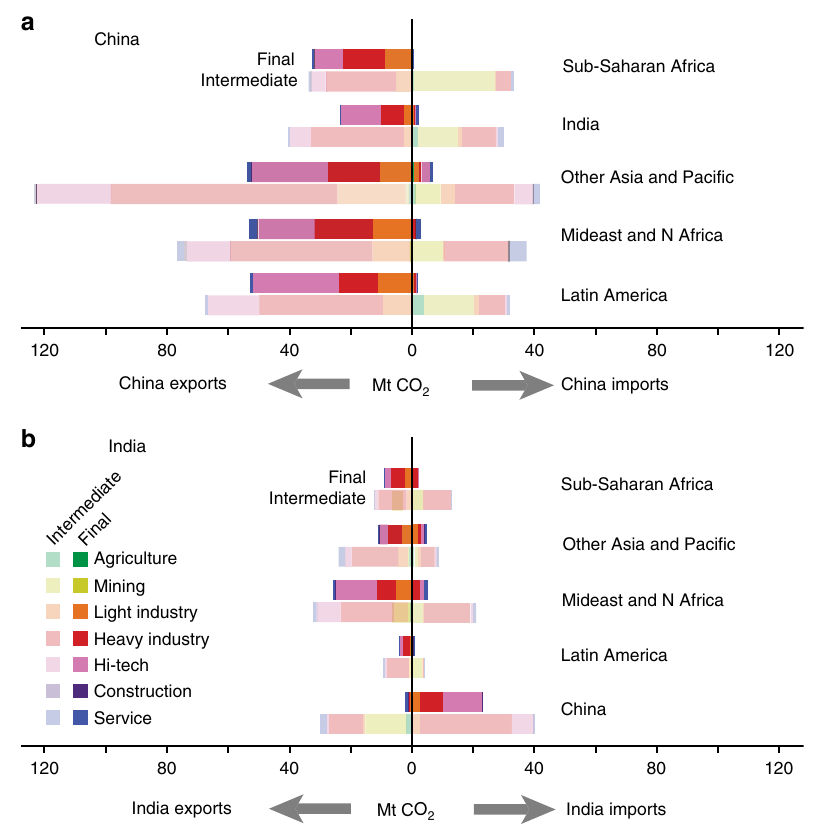
Fig. 3 Magnitude and composition of emissions embodied in trade between developing regions in 2011. The sectors are the aggregation of 57 sectors and details are shown in Supplementary Table 4. Bars show the balance of CO 2 emissions embodied in trade between developing regions and China ( a ) and India ( b ). Colors indicate the sectors of traded products, with fi nal and intermediate products differentiated by both the intensity of shading and separate